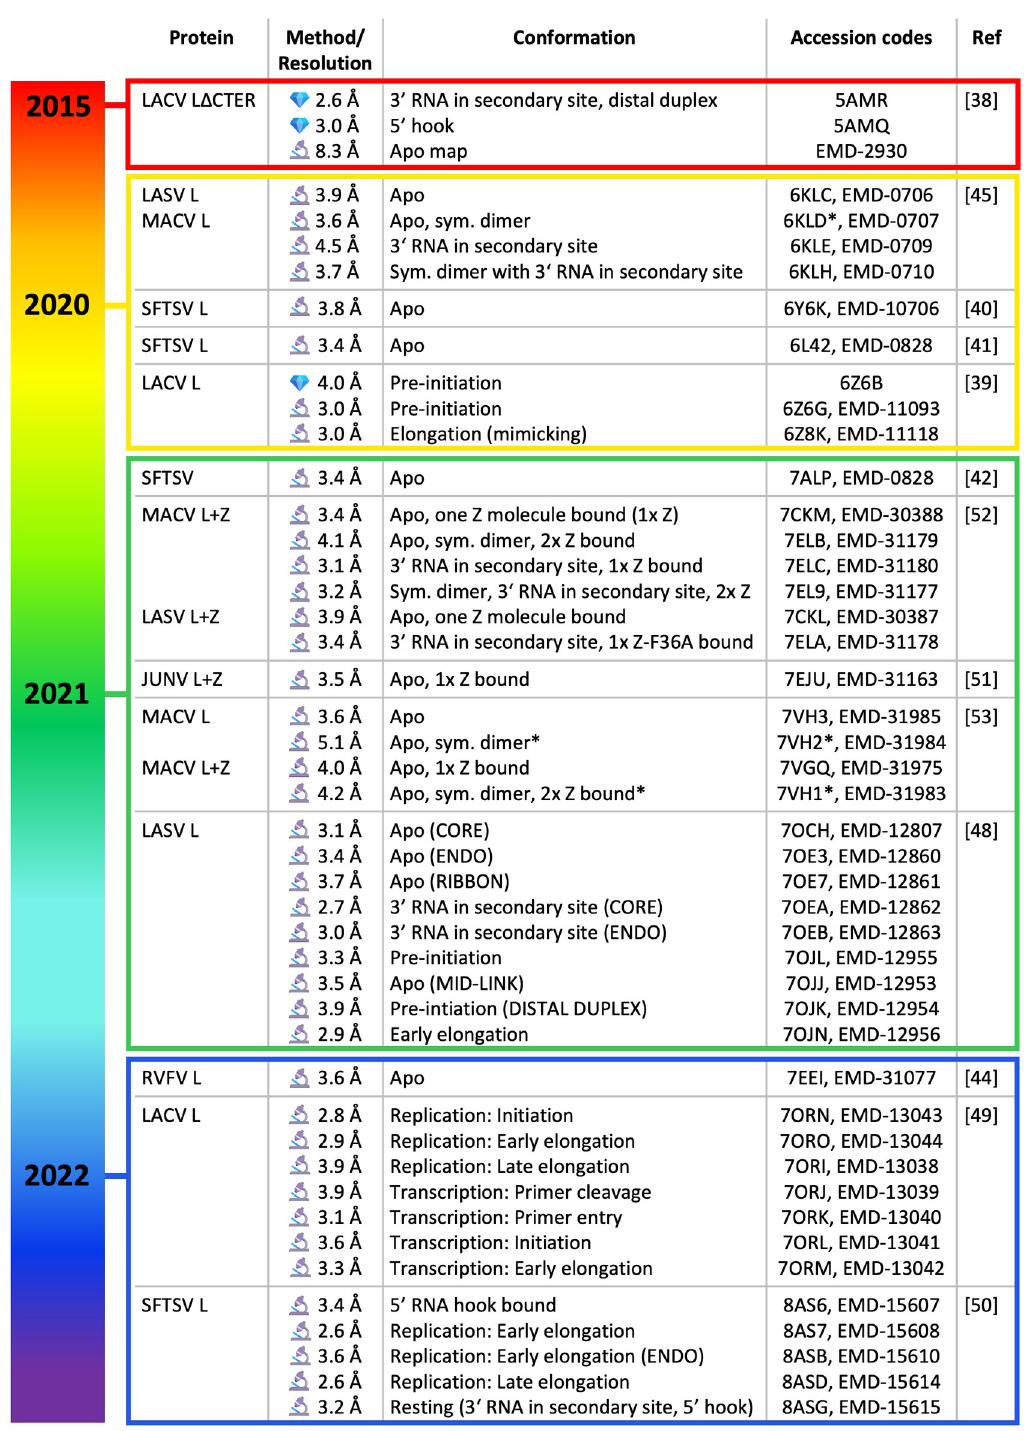
Fig 1. Overview of bunyavirus L protein structures. All published structures of bunyavirus L proteins are included in the table (JUNV, Junin virus; LACV, La Crosse virus; LASV, Lassa virus; MACV, Machupo virus; RVFV, Rift Valley fever virus; SFTSV, severe fever with thrombocytopenia syndrome virus). Some structures additionally include viral matrix protein Z (L+Z). Entries are organised firstly by year and then publication date. For each structure, the method of determination ( for X-ray crystallography, for cryo-EM) along with the calculated resolution, information on the protein conformational state